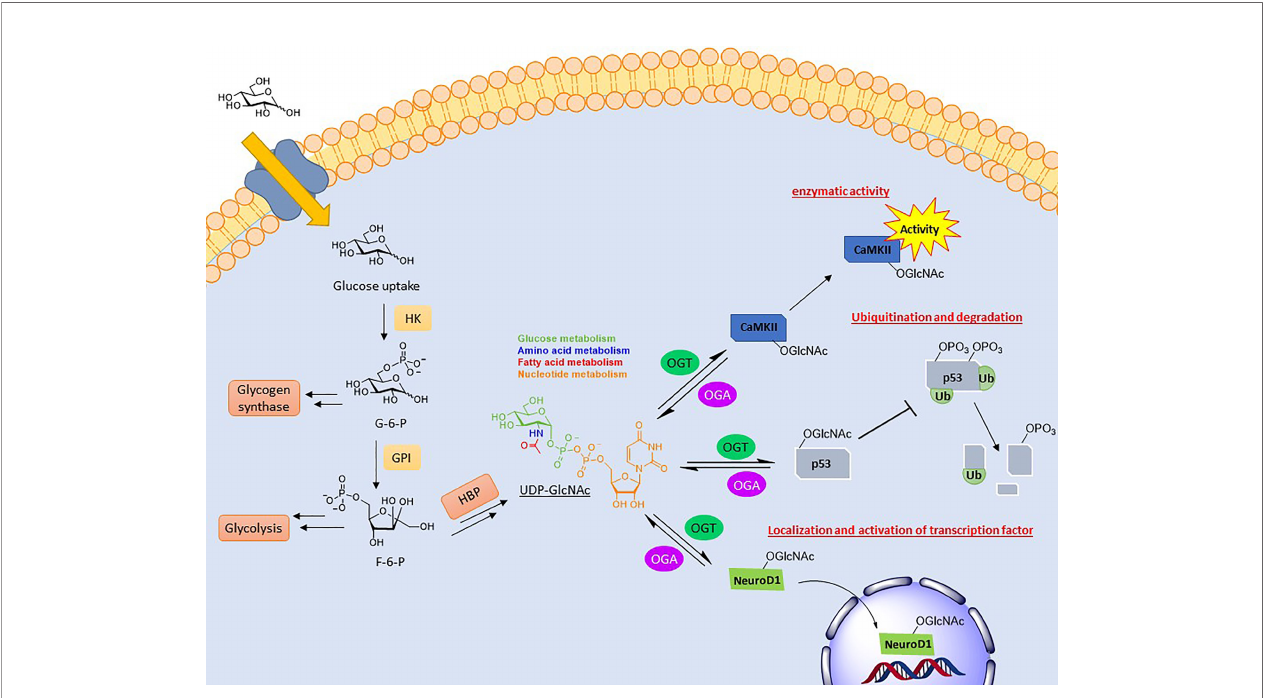
FIGURE 1 | Depiction of the biosynthesis of UDP-GlcNAc and the effects conveyed on its substrates. UDP-GlcNAc is formed through the hexosamine biosynthetic pathway (HBP), combining several metabolites. O -GlcNAc cycling can modulate activity (CaMKII), stability (p53), and localization (NeuroD1) of its